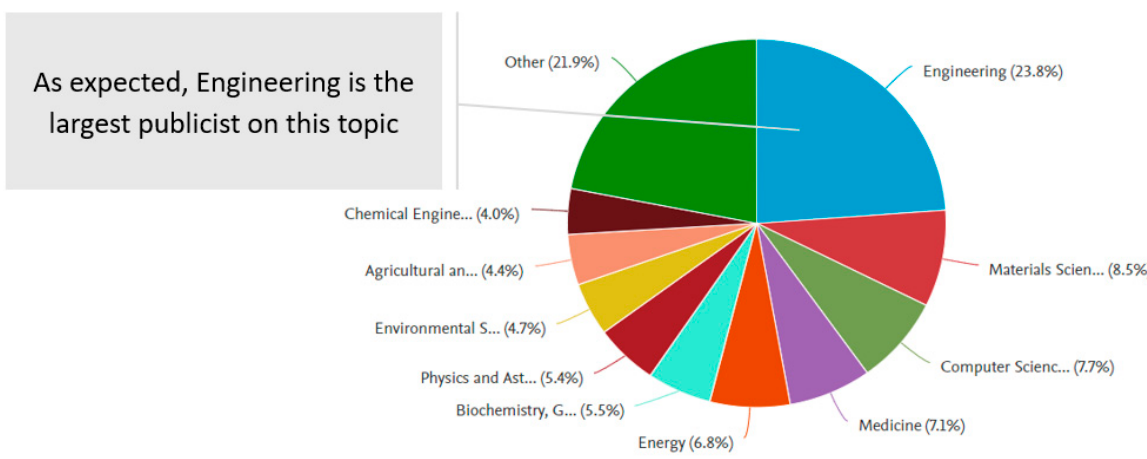
Figure 13. SCOPUS: advanced AND production AND control—Documents by subject area.